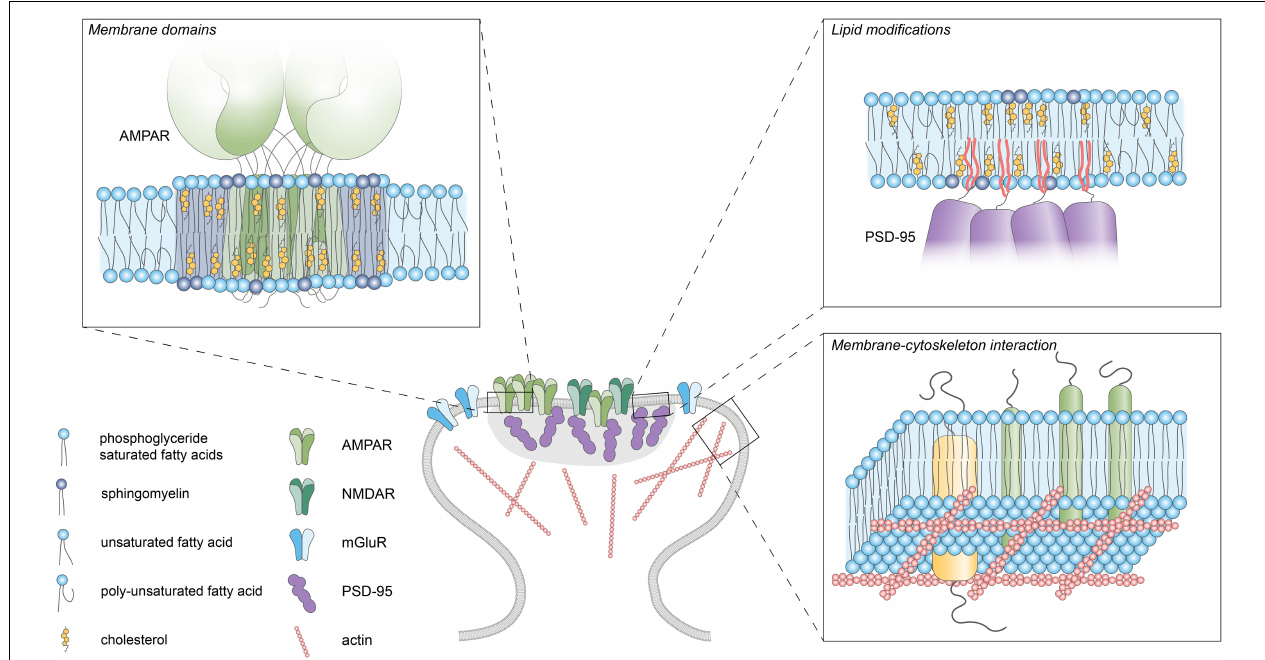
FIGURE 2 | Lipid-protein interactions. Schematic diagram of the different lipid-protein interactions within the postsynaptic plasma membrane. Membrane domains enriched in cholesterol, glycosphingolipids and saturated lipids can facilitate clustering of membrane proteins by influencing fluidity and thickness of the membrane. Reversible palmitoylation can translocate proteins to the plasma membrane. Actin-linked transmembrane proteins can act as “pickets” and hinder the diffusion of lipids and proteins within the